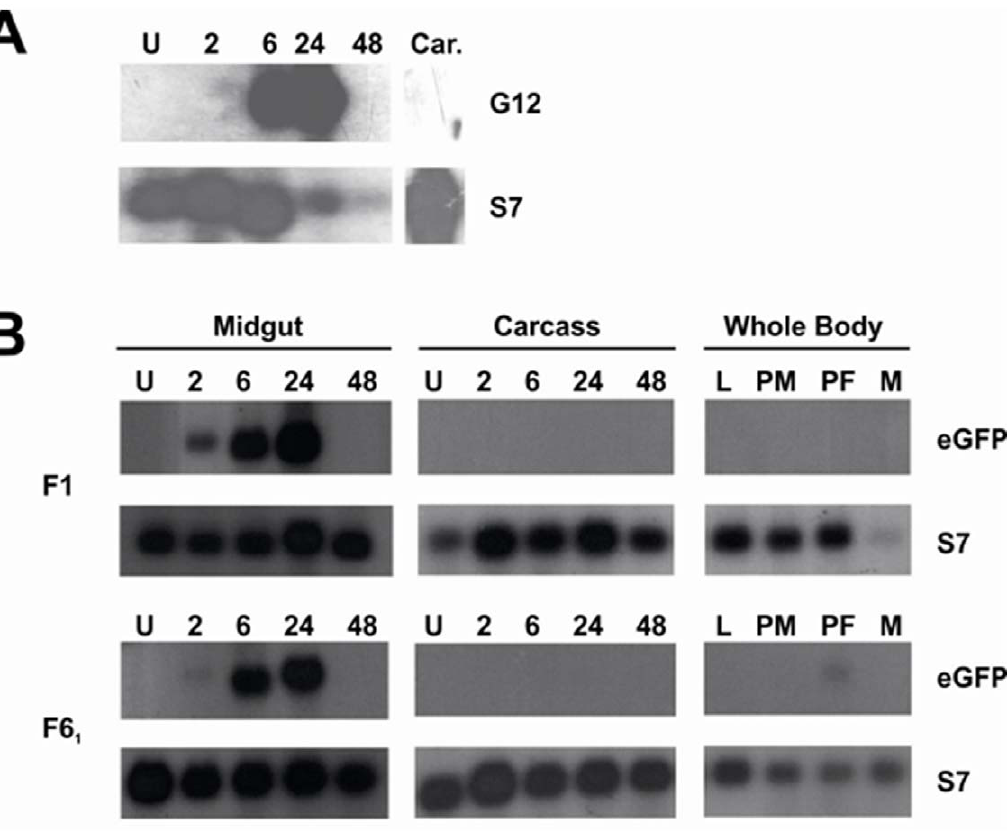
Figure 3. Reporter gene expression driven by the G12 promoter closely resembles the transcriptional of the endogenous female- specific, bloodmeal-inducible G12 gene. ( a ) Northern blot analysis was performed to profile the expression of the endogenous G12 gene in A. gambiae . We detected maximal expression in midguts 24 hours PBM. No expression was detected in the carcass at this timepoint (Car.), or at any other time point (not shown). As an internal loading control, blots were stripped and re-probed for the ubiquitous ribosomal S7 gene. ( b ). Northern blot analysis of EGFP transcription under the control of the A. gambiae G12 promoter in transgenic A. stephensi. Two independent transgenic lines (F1 and F6 1 ) were tested. Stages and tissues tested were whole males (M), L3/L4 larvae (L), pupae (P), dissected midguts and carcasses unfed (U) and 2,6,24 and 48 hours PBM